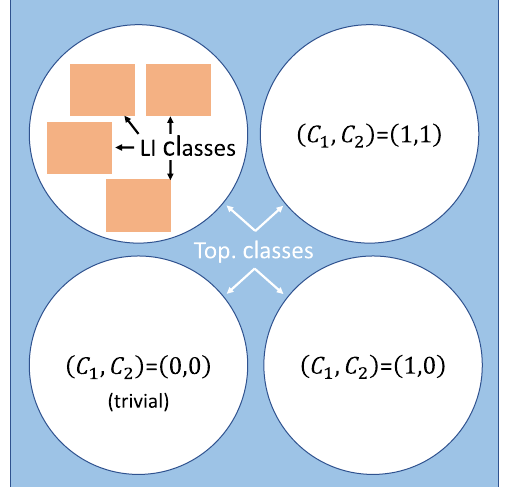
FIG. 5. Topological equivalence classes for d ¼ 1 quasicrystals are labeled by a pair of integers ð C 1 ; C 2 Þ (see Secs. V and VIII). Each class consists of physically inequivalent LI classes which are equivalent